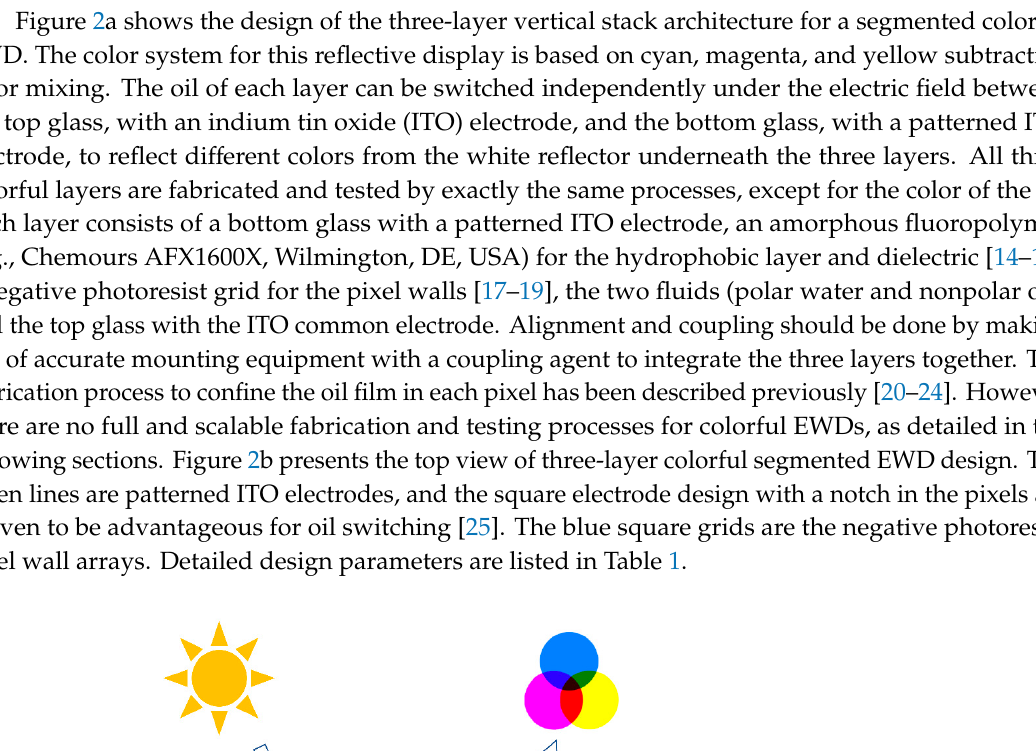
Table 1. Design parameters of a colorful segmented electrowetting display